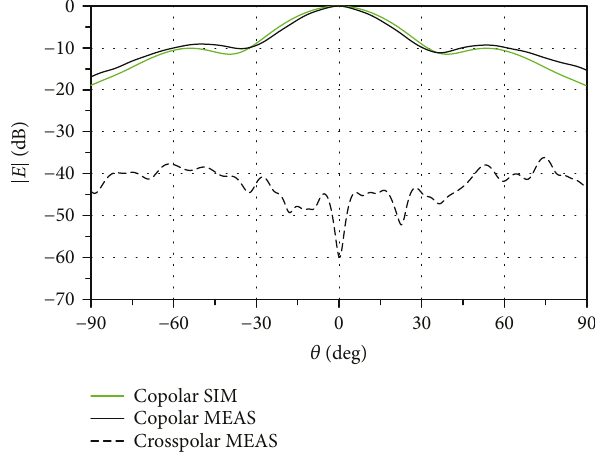
parameter of the proposed lens antenna. 11